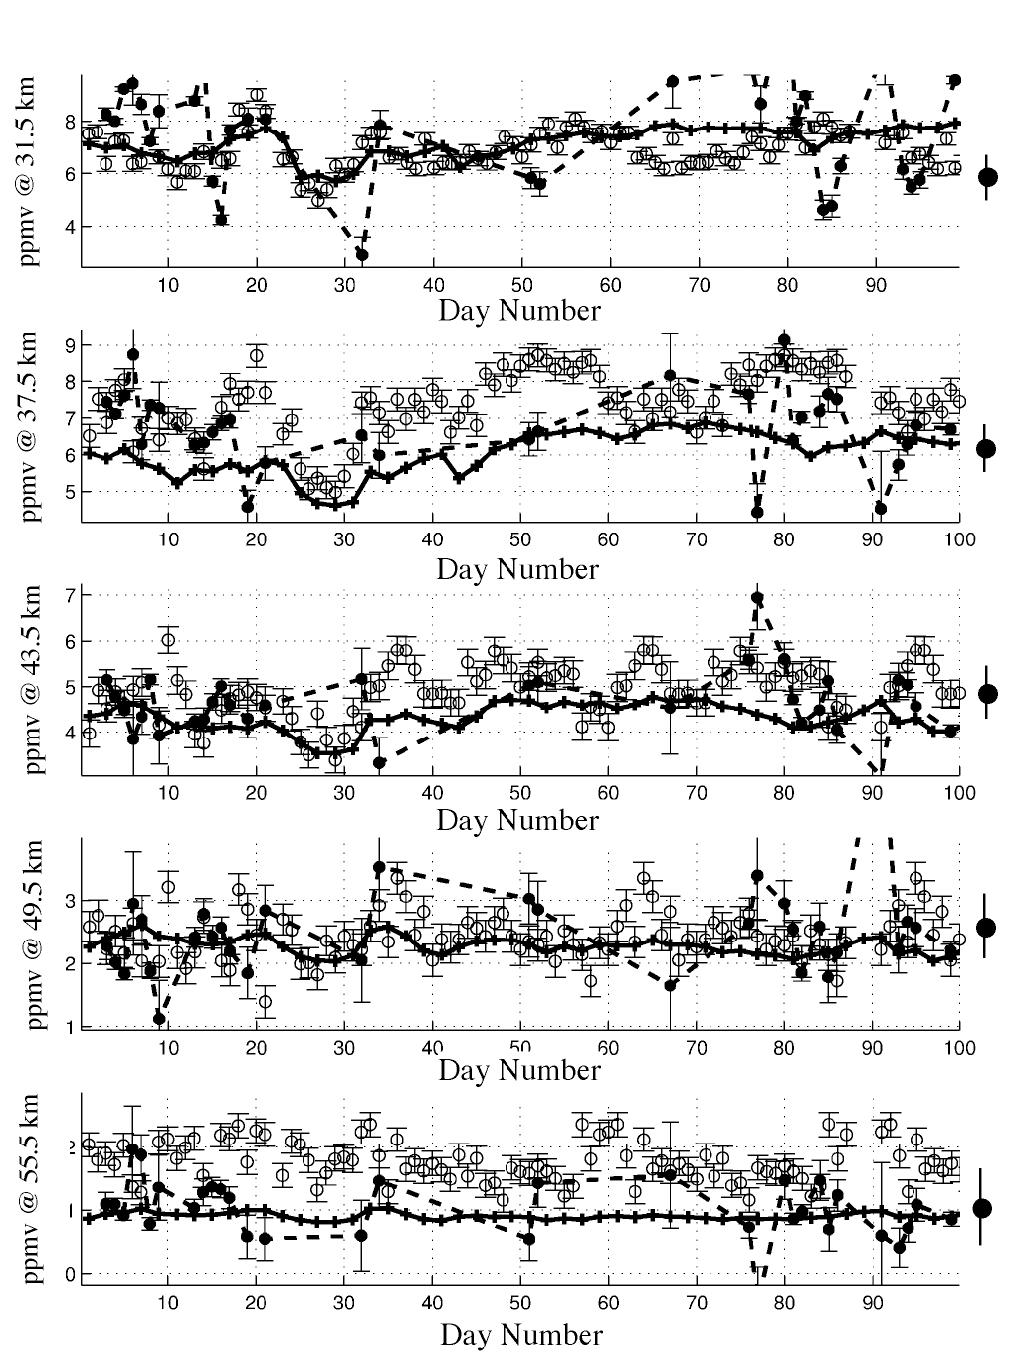
Fig. 12. Variations of O 3 VMR from January to April 1995 at 31.5, 37.5, 43.5, 49.5 and 55.5km (from top to bottom), as retrieved from measurements by the radiometer installed at the Plateau de Bure (filled circles connected by dashed line) and by the radiometer installed at Bern (Switzerland) (open circles) and as calculated by the 3-D CTM SLIMCAT model (crosses connected by solid line) within the same layers. Note that vertical resolution of the model has been degraded to match the resolution of the ground-based measurements. Only an uncorrelated 1- σ error due to the thermal noise is considered in the errorbar. A systematic 1- σ error for the Bure measurements (filled circle and thick line) is represented on the right-hand side of each